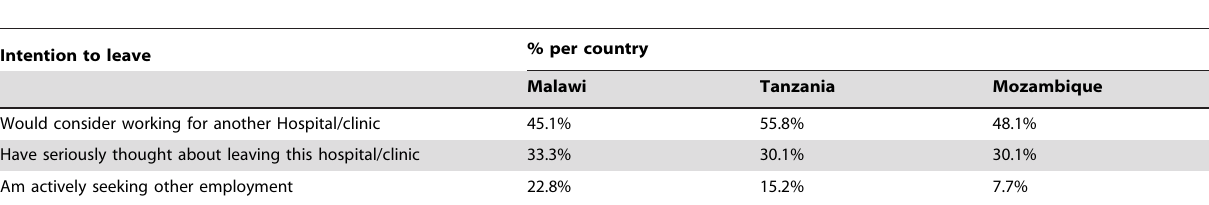
Table 2. Percentage of health workers in each country who have considered leaving their current